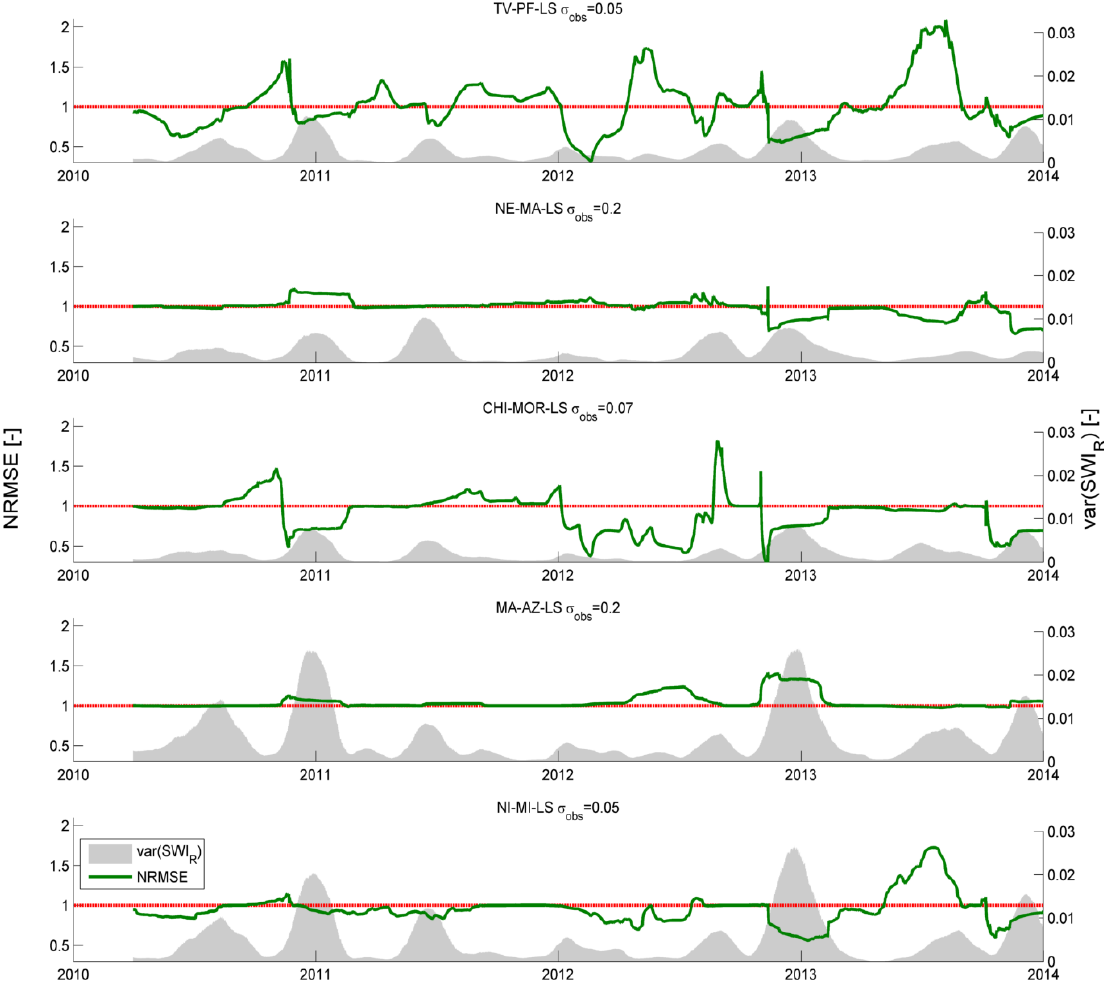
Figure 6. Pattern of the Normalized Root Mean Squared error (NRMSE ) and variance of the rescaled Soil Water Index (rescaled with LR technique), 2 catchments calculated with a time window of 90 days. Values above the red horizontal line ( NRMSE = 1) denote deteriorations. Periods of increased 2 improvements except for